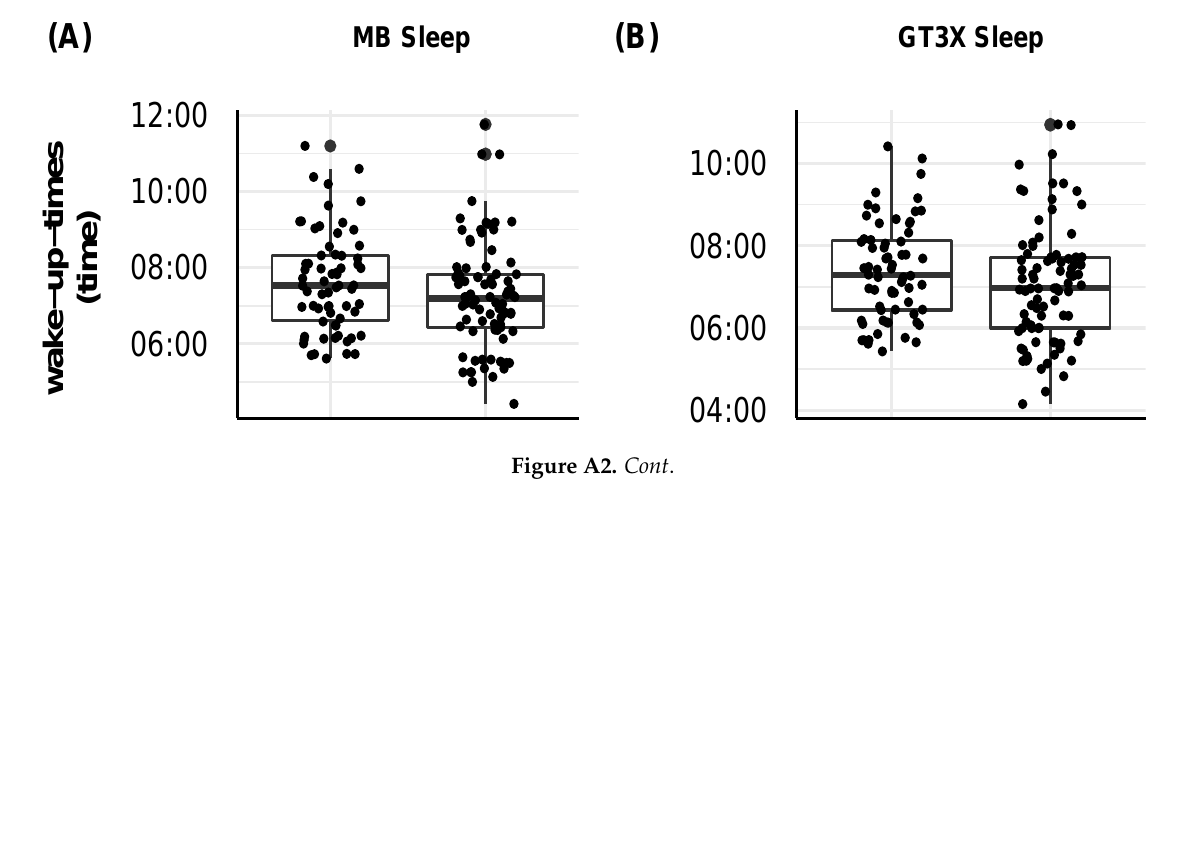
Figure A1. Exemplary step counts as extracted by MB and the GT3X for two participants ( A , B ). Note that on many occasions, the GT3X (right) counted steps when MB (left) did not. Note that the GT3X marked some periods as active, whereas for the same periods, MB indicated 0 activity.